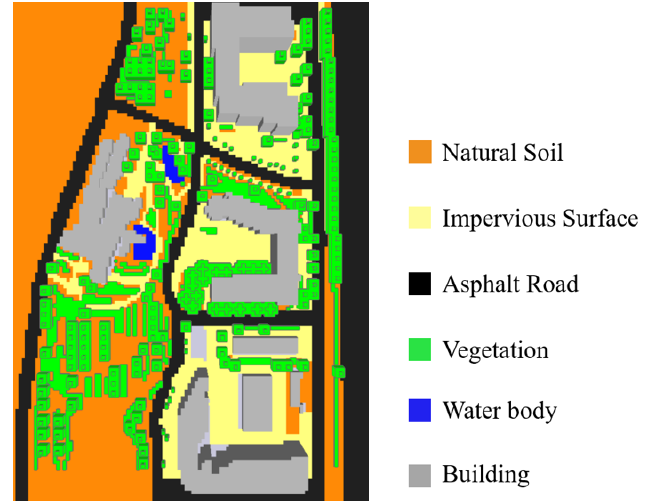
Figure 4. Top view of the simulated area for the actual conditions. Table 3. Simulation conditions used in ENVI-met.